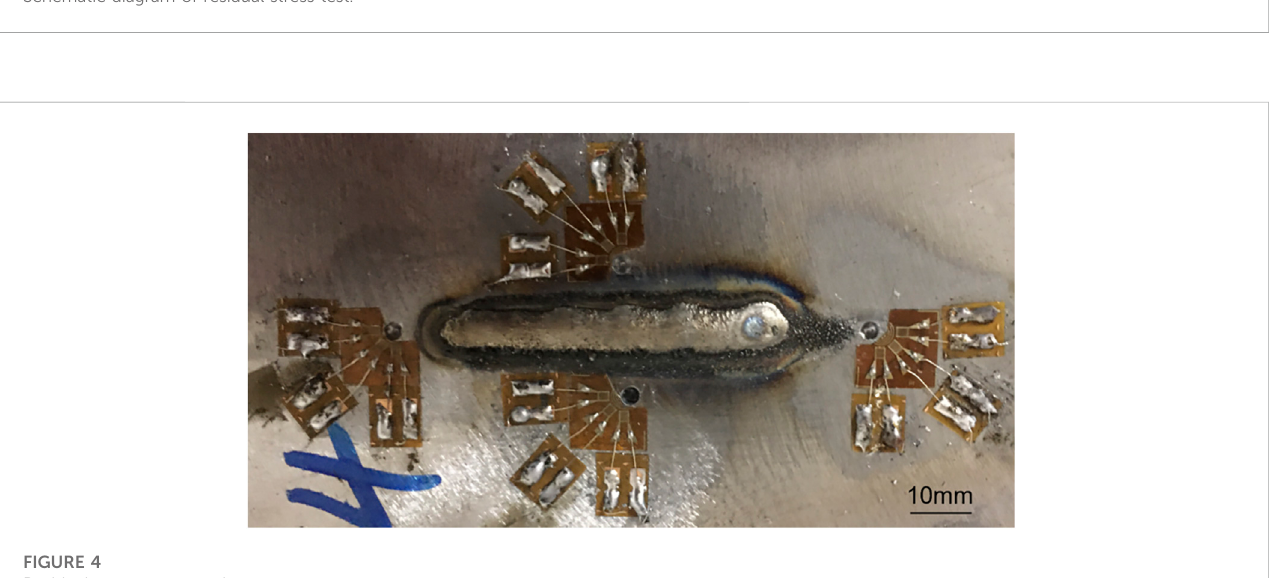
FIGURE 4 Residual stress test